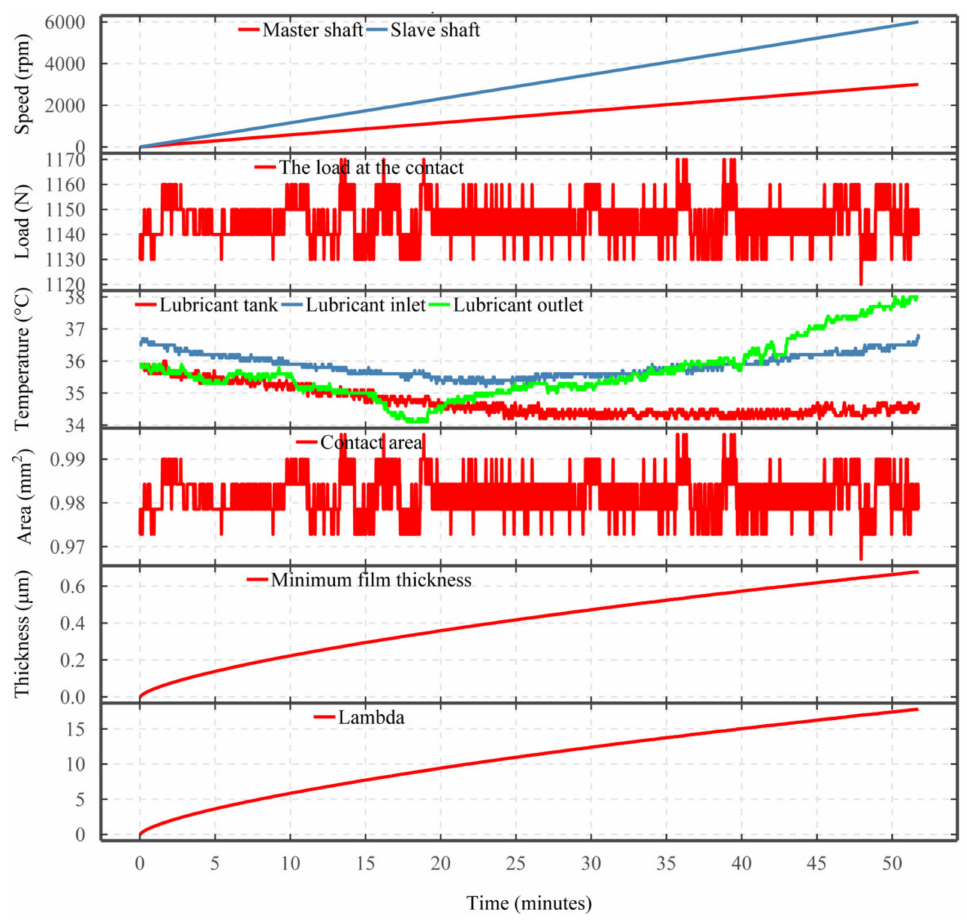
Figure 4. The responses from the test rig sensors and the calculated contact area, minimum film thickness, and lambda based on the initial roughness measurement. Table 4. Details of the tests; 1 incremental rate of 1 rpm/s, 2 incremental rate of 0.54 N/s, 3